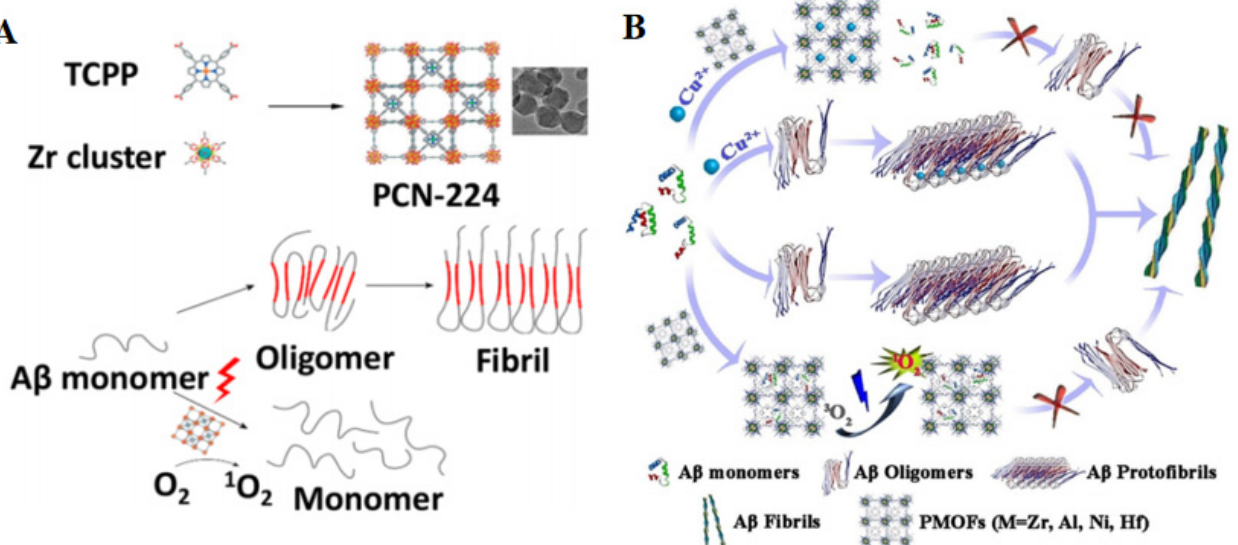
Figure 13. ( A ) Schematic diagram of the photo-inhibition of A β 1–42 aggregation using PCN-224 nanoparticles. Reprinted with permission from reference [160]. Copyright 2018 American Chemical Society. ( B ) Schematic illustration of the possible mechanism of inhibition effect of porphyrinic MOFs on the amyloid fibrillation process. Reprinted with permission from reference [162]. Copyright 2019 Wiley-VCH.